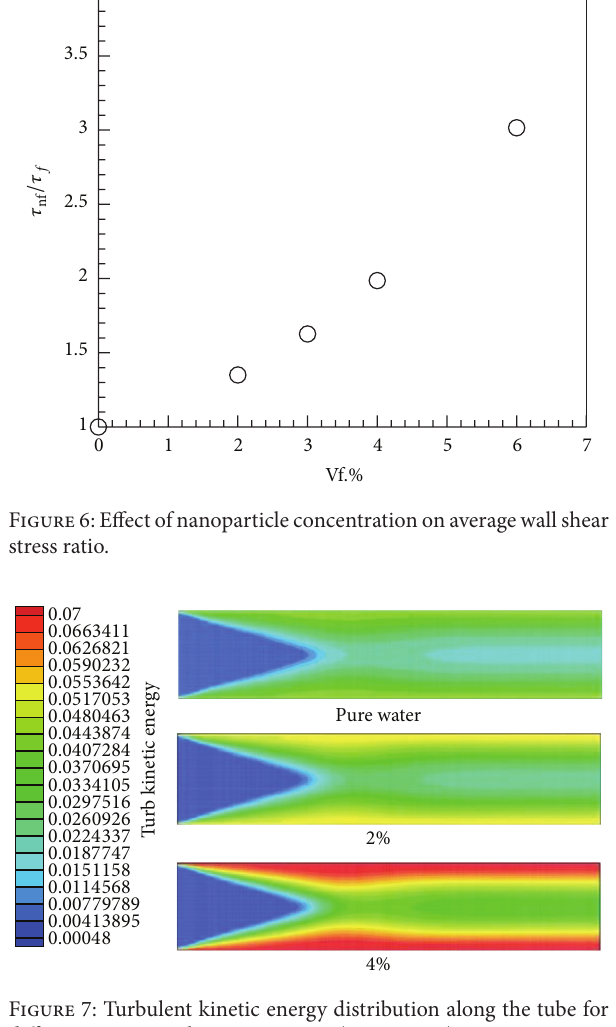
Figure 7: Turbulent kinetic energy distribution along the tube for different nanoparticle concentration (Re =